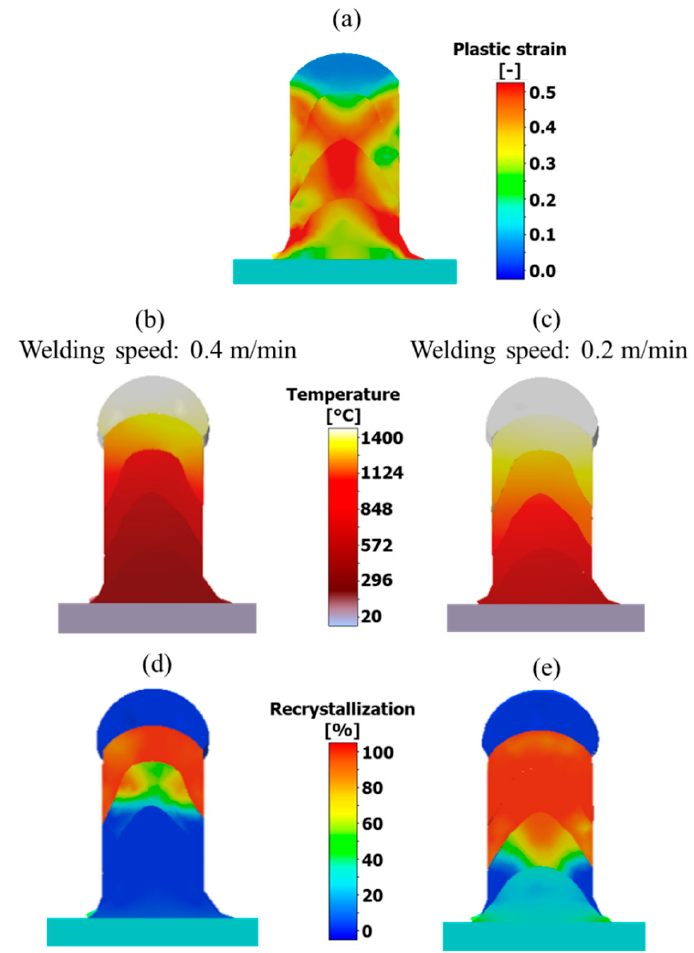
Figure 5. Strategy 2 (decoupled process), ( a ) initial plastic strain in 4 layers cross section after cold forming, ( b ) temperature distribution after 5th layer for welding speed of 0.4 m/min, ( c ) temperature distribution after 5th layer for welding speed of 0.2 m/min, ( d ) amount of recrystallization after 5th layer for welding speed of 0.4 m/min, ( e ) amount of recrystallization after 5th layer for welding speed of 0.2 m/min. The shown state is at the same time step after finishing welding the 5th layer for ( b – e ) for comparison.